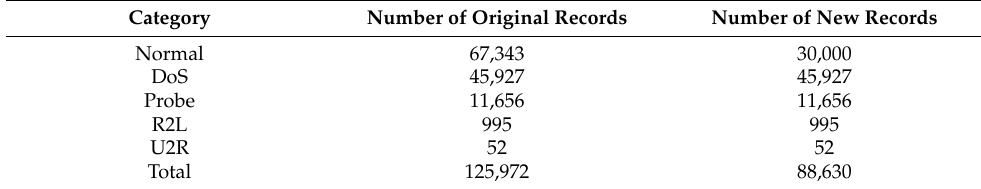
Table 2. Number of New